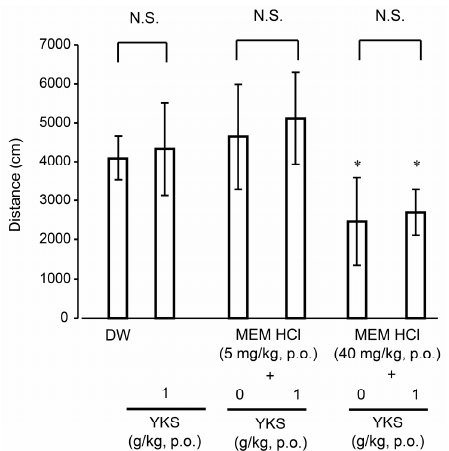
Figure 5. Effects of MEM, YKS, and their combination on locomotor activities in mice in an open-field test. Locomotor activity (total distance traveled in a quadrangular open-field apparatus) for 10 min was measured 1 h after oral administration of MEM hydrochloride (5 or 40 mg/kg), YKS (1 g/kg), or their combination. Data represent mean ± standard deviation ( n = 10). * p < 0.05 versus DW-treated control (Tukey–Kramer test following one-way ANOVA). N.S.: no statistical significance was